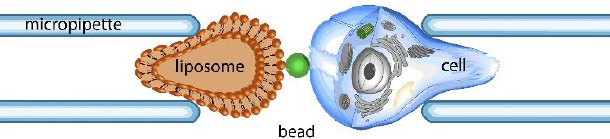
Figure 8. Schematic illustration of a biomembrane force probe. A liposome is sucked into a micropipette that is biochemically glued to a latex bead. By pushing or pulling the liposome, a force can be exerted on the bond between the cell and the bead. As the latter can be coated with a protein of interest, receptor-ligand bonds can be studied under a controllable loading rate and force. (Reproduced with permission from [18]).